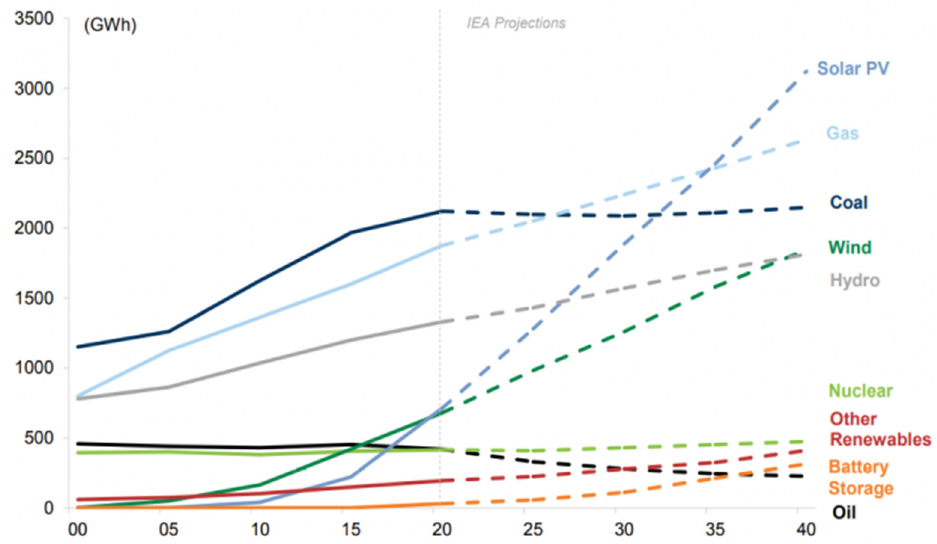
Figure 1. Power generation capacity by a source according to IEA forecasts. Source: [50].